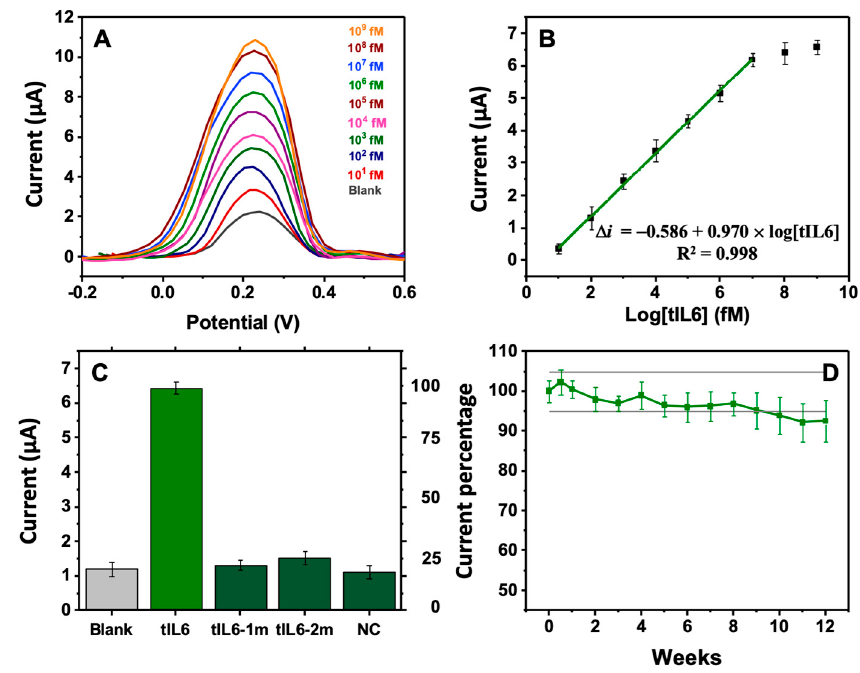
Figure 2. ( A ) SWV curves of pIL6/MBs in presence of increasing concentrations of the tIL6 sequence. ( B ) Calibration plot for the tIL6 sequence showing the dynamic range equation, ( C ) currents and percentages obtained with 500 pM of tIL6, or 5.0 nM of tIL6-1m, tIL6-2m, or the noncomplementary sequence compared with the blank response, and ( D ) stability response of the bioconjugate assayed over a period of three